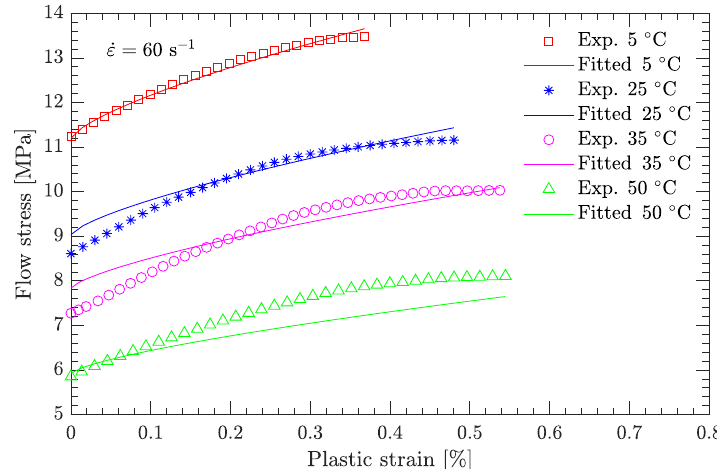
Figure 15. Comparison of fitted and measured flow stresses at a strain rate of 60 s − 1 .